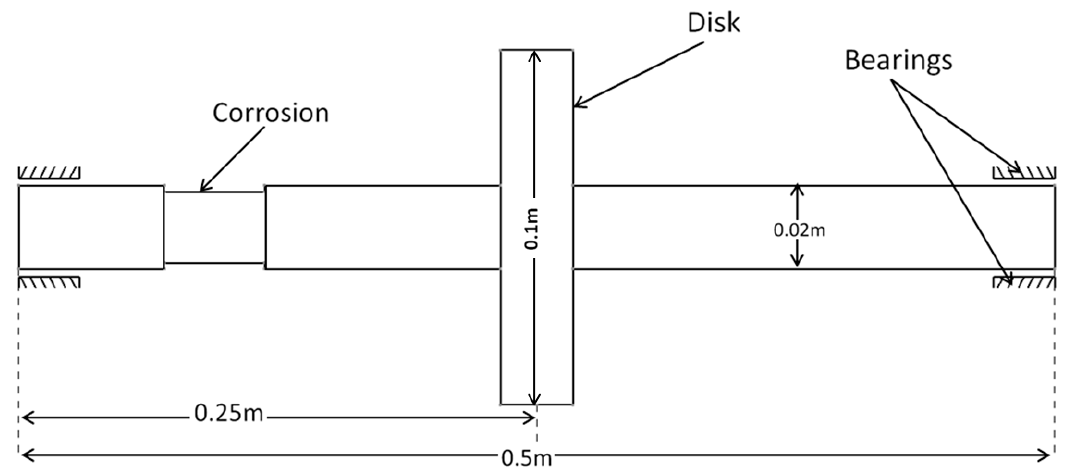
Figure 2. Functionally graded rotor-bearing system with a corrosion defect.